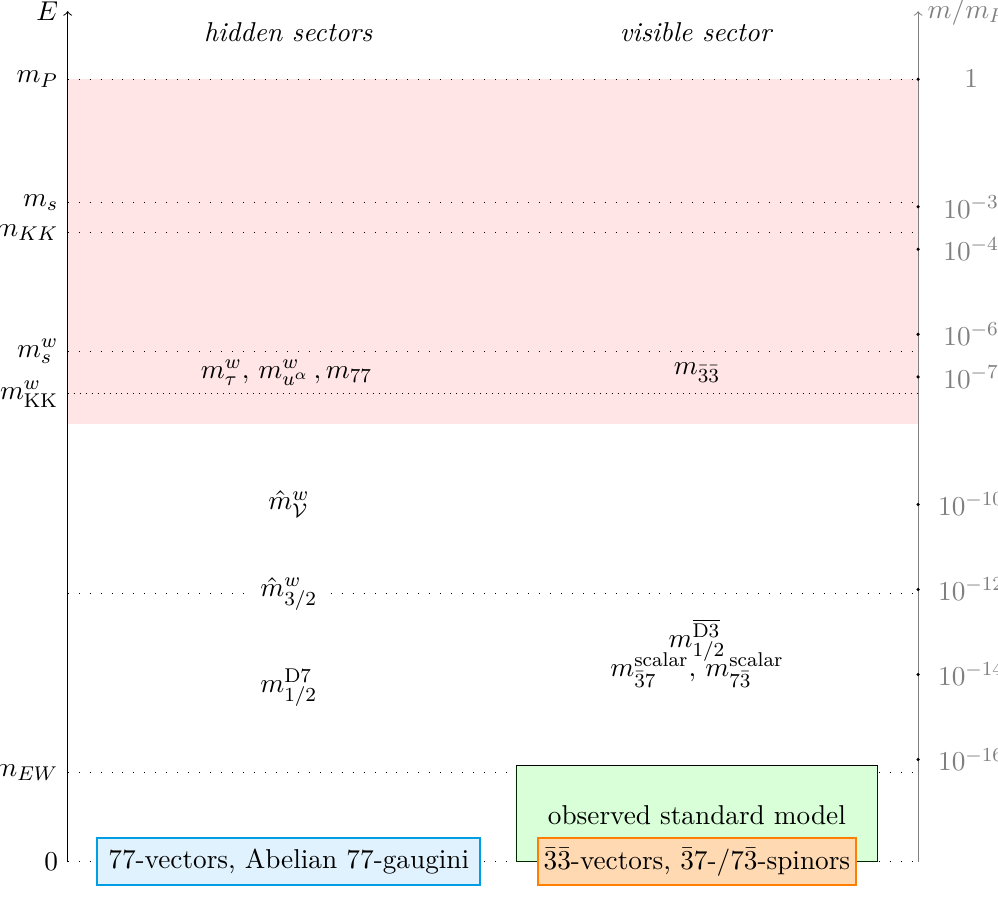
Figure 3 . A qualitative sample of the mass scales in models with intersecting anti-D3- and D7- branes in highly warped compactifications, i.e. such that hVi 2 / 3 ≤ e − A 0 , with KKLT-like non- perturbative corrections and α 0 -corrections, and a small bulk (0 , 3) -flux such that the gravitino localises in the bulk. Where the spin is not indicated, the masses refer to the supermultiplet as the soft-breaking corrections do not dominate. The observed standard model energy range and the relevant scales above the cutoff are shown explicitly. The graph refers to an anti-D3-brane sitting at the throat tip and a D7-brane wrapping a 4-cycle extending from the tip into the bulk, with the D7-brane chiral multiplet localised at the tip, where the gauge couplings are g 2 g 2 ∼ 2 · 10 − 3 . A similar spectrum emerges if the D7-brane wraps a 4-cycle localised at the tip, D7 with then the D7-brane scales similar to the anti-D3-brane scales, so g 2 If the D7-brane wraps a 4-cycle extending into the bulk and the mass-sourcing (2 , 1) -fluxes are such that the D7-brane chiral multiplet localises in the bulk, then the latter approaches the gravitino mass scale, m 77 ∼ ˆ m w 3 / 2